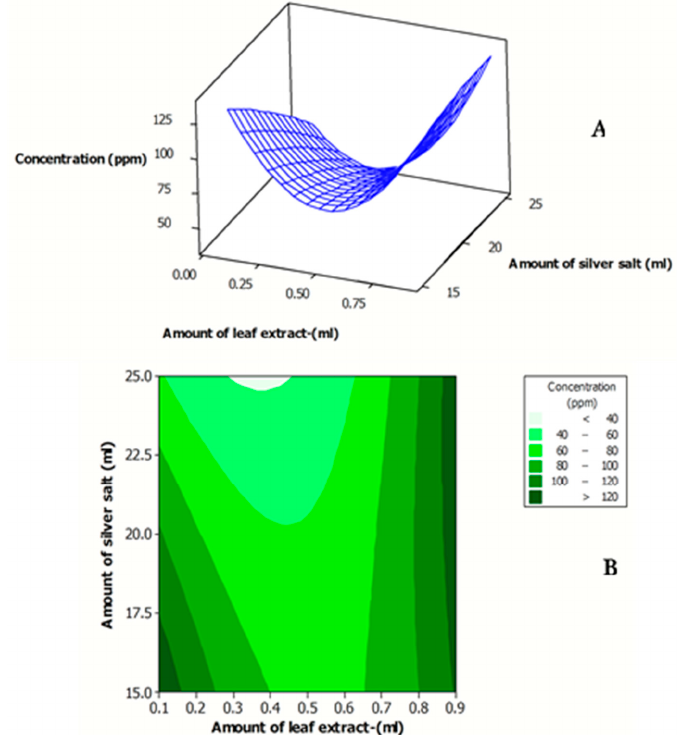
Figure 4. Response surface ( A ) and contour plots ( B ) for the concentration of the synthesized Ag NP solution as function of amount of J. regia leaf extract and amount of AgNO 3 solution.